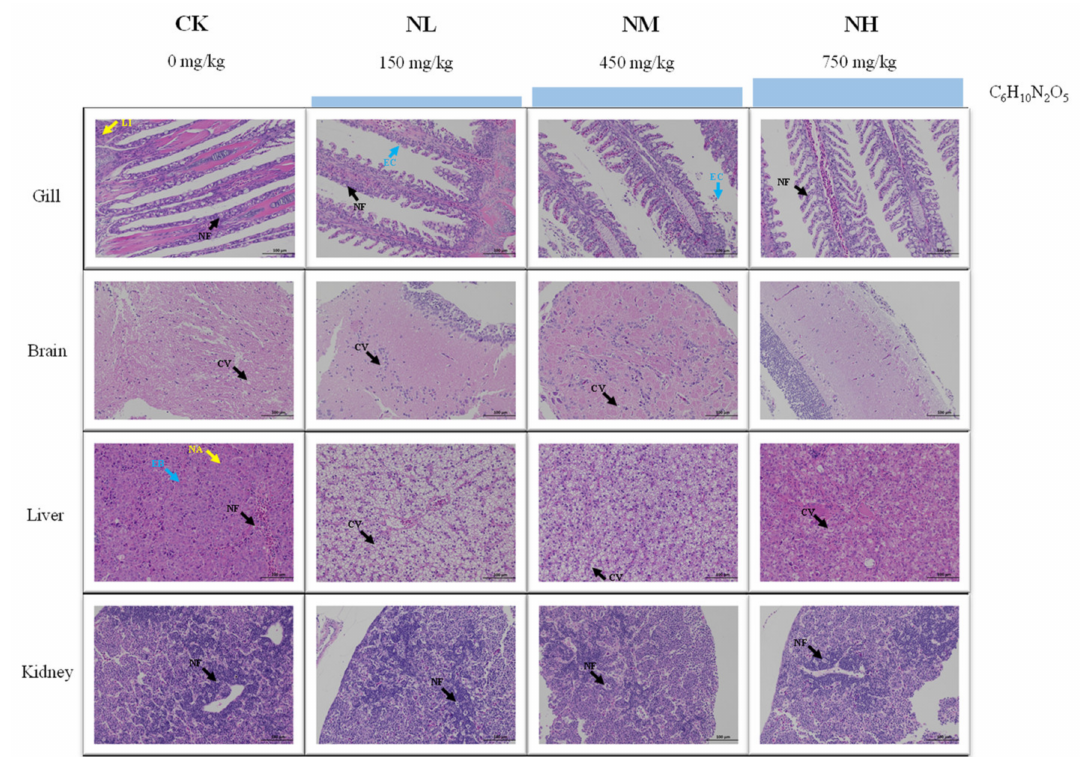
Figure 7. Effect of NCG on histology of juvenile M. salmoides under ammonia stress. NF: nuclear fragmentation; LI: lymphocyte infiltration; EC: epithelial cells; CV: cytoplasmic vacuolization; EB: eosinophilic bodies; NA: nucleolar